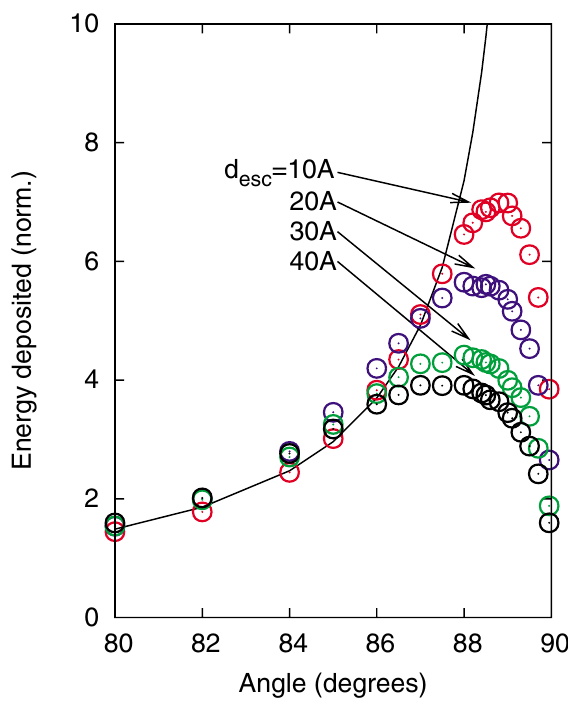
FIG. 2. (Color) Simulations of energy deposited as a function of angle of incidence of the ion measured from the surface normal for different thicknesses of target material. The depos- ited energy is normalized to the energy at the least grazing angle. Varying the thickness in the simulations allows one to . These results are for 1.0 MeV see the effect of varying d esc potassium hitting a stainless steel